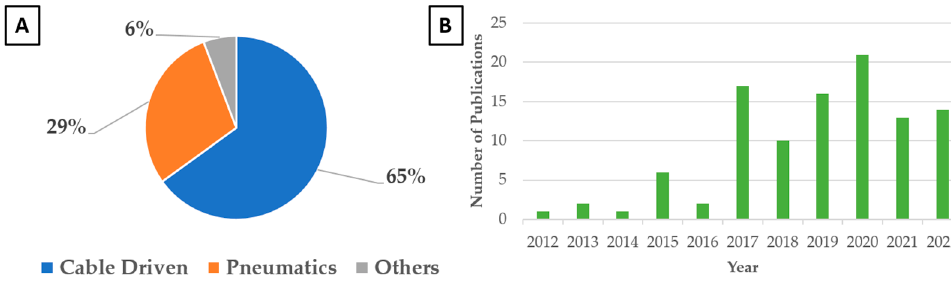
Figure 2. ( A ) Breakdown of relevant publications by actuation mechanisms over the past decade. ( B ) Breakdown of relevant publications by year.